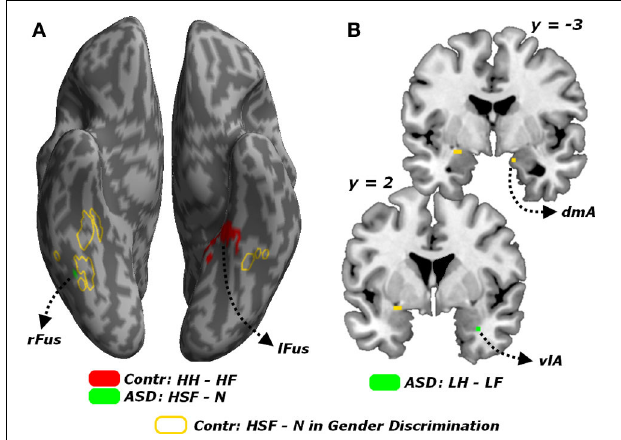
FIGURE 8 | Passive viewing sessions. (A) Whole-brain maps showing significant increase of neural activity associated with the contrast HH − HF in Controls (red blob) the contrast HSF - N in ASD individuals (green blob). Activations are overlaid on an inflated brain surface. (B) Coronal sections ( y = − 3, 2) displaying the increase of neural activity for the contrast LH − LF in ASD individuals (green blobs) in the right amygdala. For both (A,B) portions of fusiform and amygdalar cortex implicated in the contrast HSF − N in earlier analysis on the gender discrimination sessions are displayed in yellow. Fus , Fusiform Gyrus; r and l , right and left hemisphere respectively. dmA and vlA, dorsomedial and ventrolateral portions of the